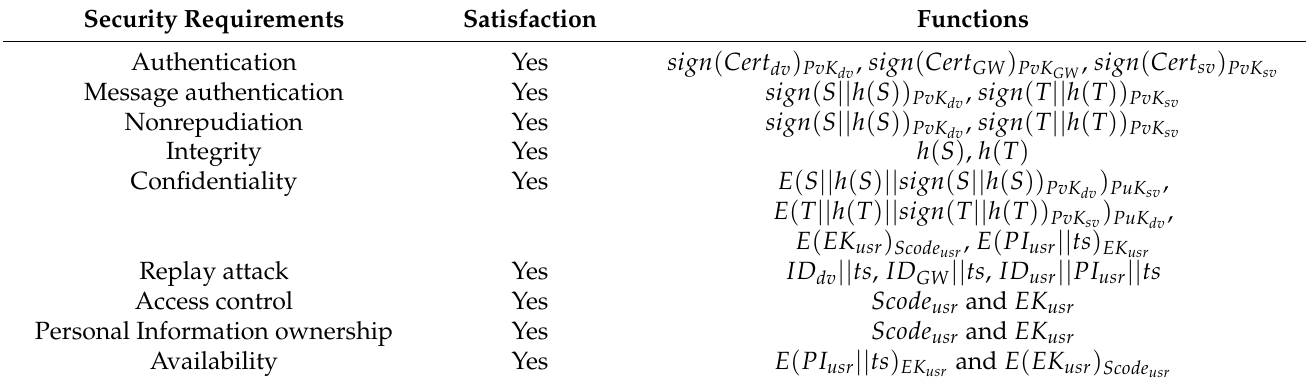
Table 3. Satisfaction of security requirements by the proposed method.